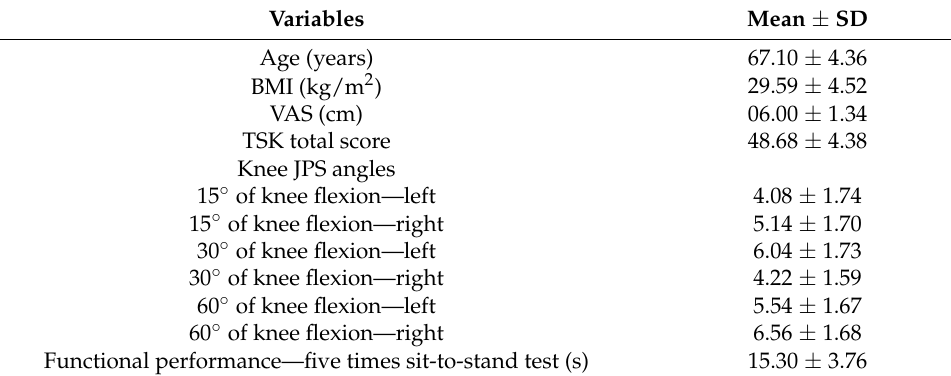
Table 1. Characteristics of the study participants ( n = 50).